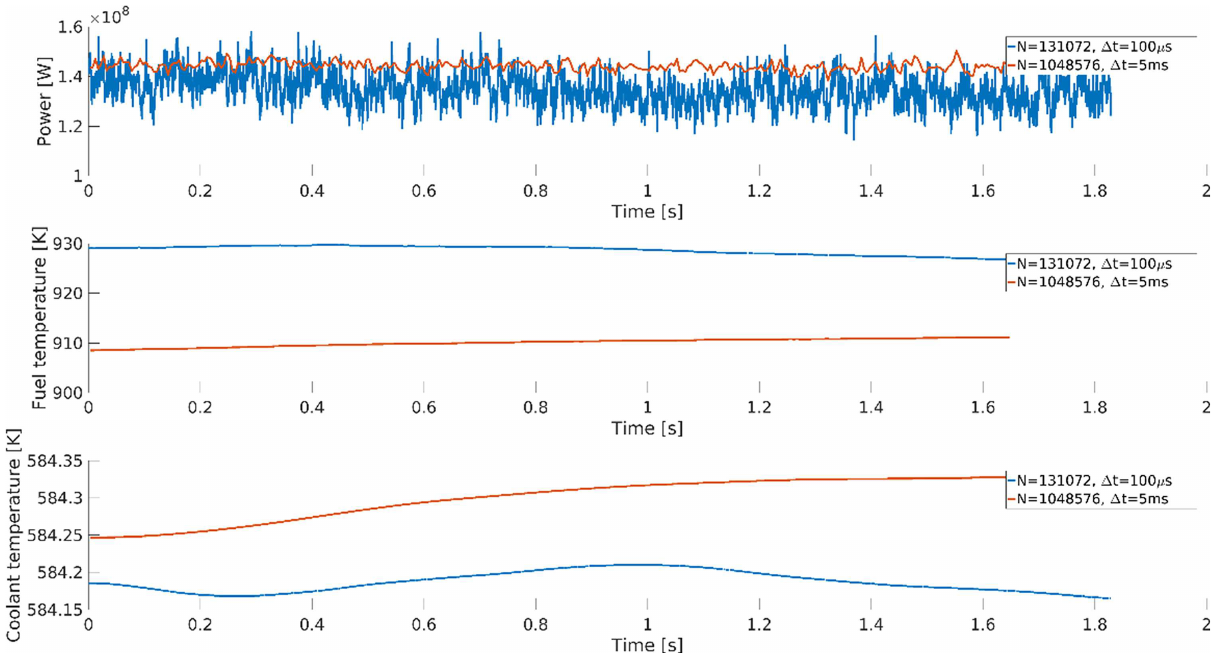
Fig. 9. Dynamic simulation average power, fuel, and coolant temperatures, for Run #1 (red) and Run #2